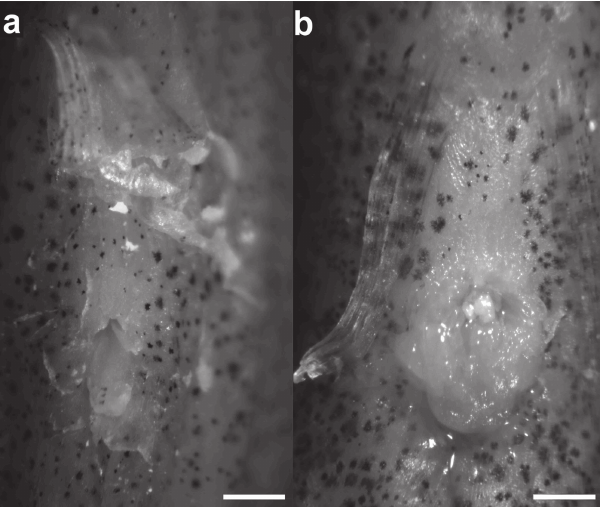
Fig. 3. Urogenital papillae of Kryptolebias hermaphroditus in ventral view; UFRN 3374: a, cylindrical shape in male, 30.1 mm SL; b, pocket shape in hermaphrodite, 35.5 mm SL. Scale bars = 1 mm.